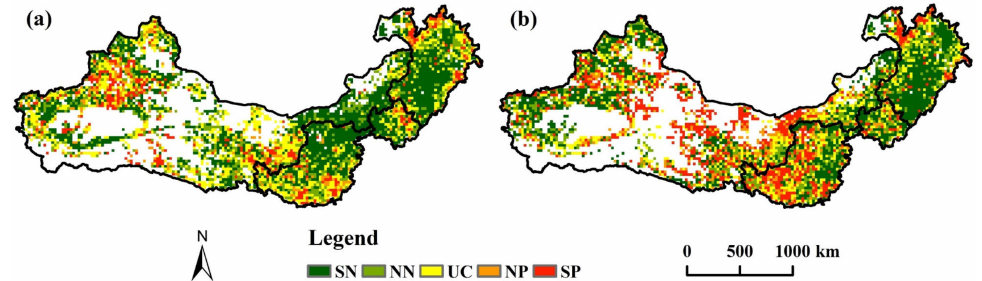
Figure 9. Spatial correlations between wind erosion and ( a ) area proportion of the forest and shrubland and ( b ) quality of the forest and shrubland (the quality index calculated by LAI × NPP). SN: significant negative correlation; NN: nonsignificant negative correlation; UC: uncorrelated; NP: nonsignificant positive correlation; SP: significant positive correlation.